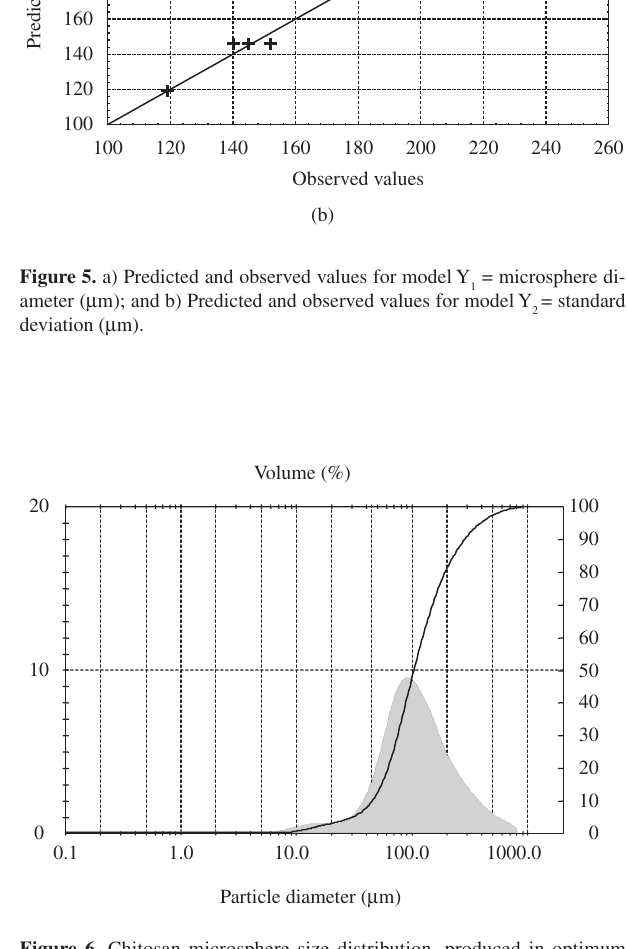
Figure 6. Chitosan microsphere size distribution, produced in optimum conditions for nitrogen pressure, 2.5 kgf.cm –2 , and for chitosan solution flow rate, 9